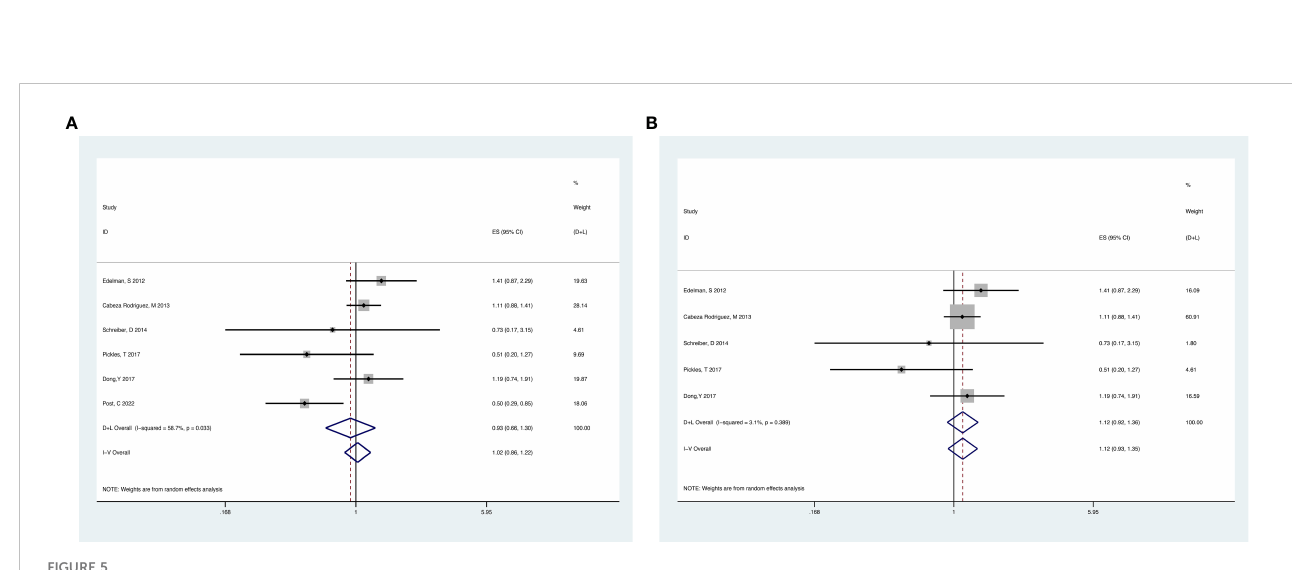
FIGURE 4 Forest plot for OS of 4 RCTs.